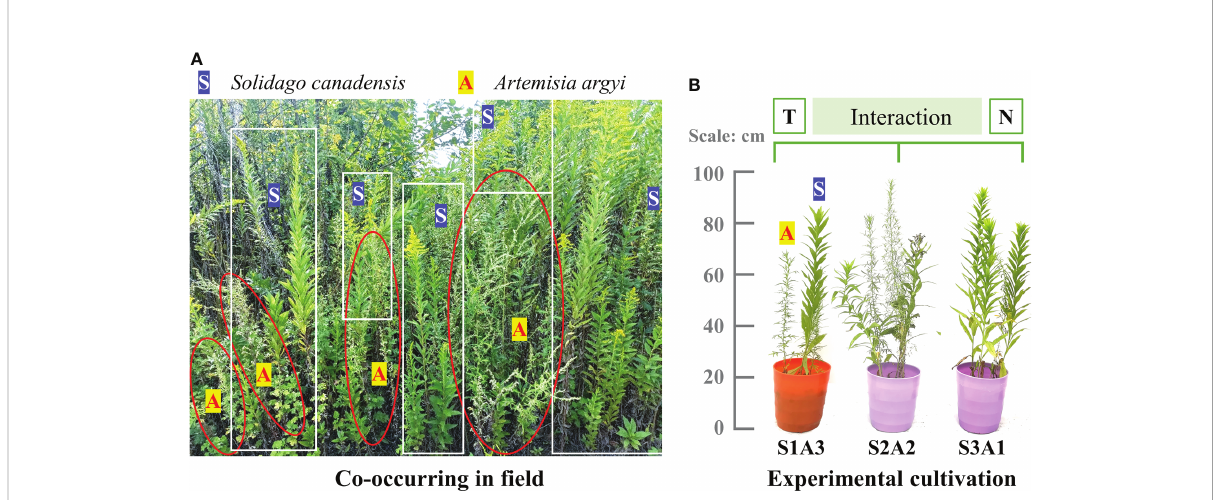
FIGURE 1 Target species: invasive S. canadensis (white S on blue) and native A argyi (red A on yellow) co-occurring in fi eld (A) and cultivation in our experiment (B) . T, N, S, and A indicates temperature, nitrogen, invasive S. canadensis and native A argyi ,